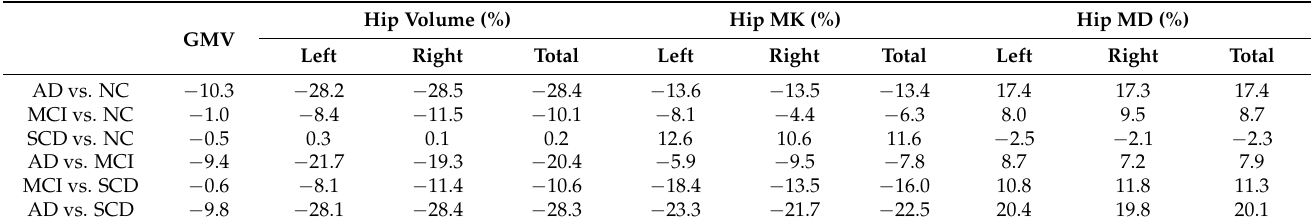
Figure 5. Typical subjects for AD, MCI, SCD, and NCs. The red square contains the bilateral hippocampus. The atrophy of the bilateral hippocampus for AD is the most severe; MCI is intermediate. There was no hippocampal atrophy for SCD compared with NCs. Table 3. Percentage change of measurements for each pair-wise comparison.